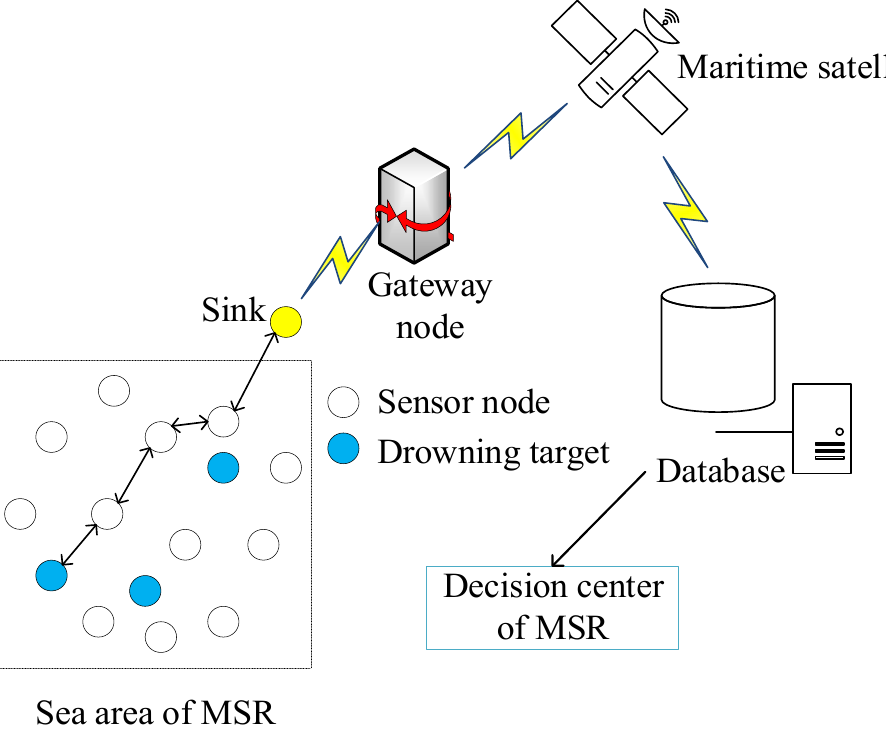
Figure 1. System model of the MSR-WSNs.